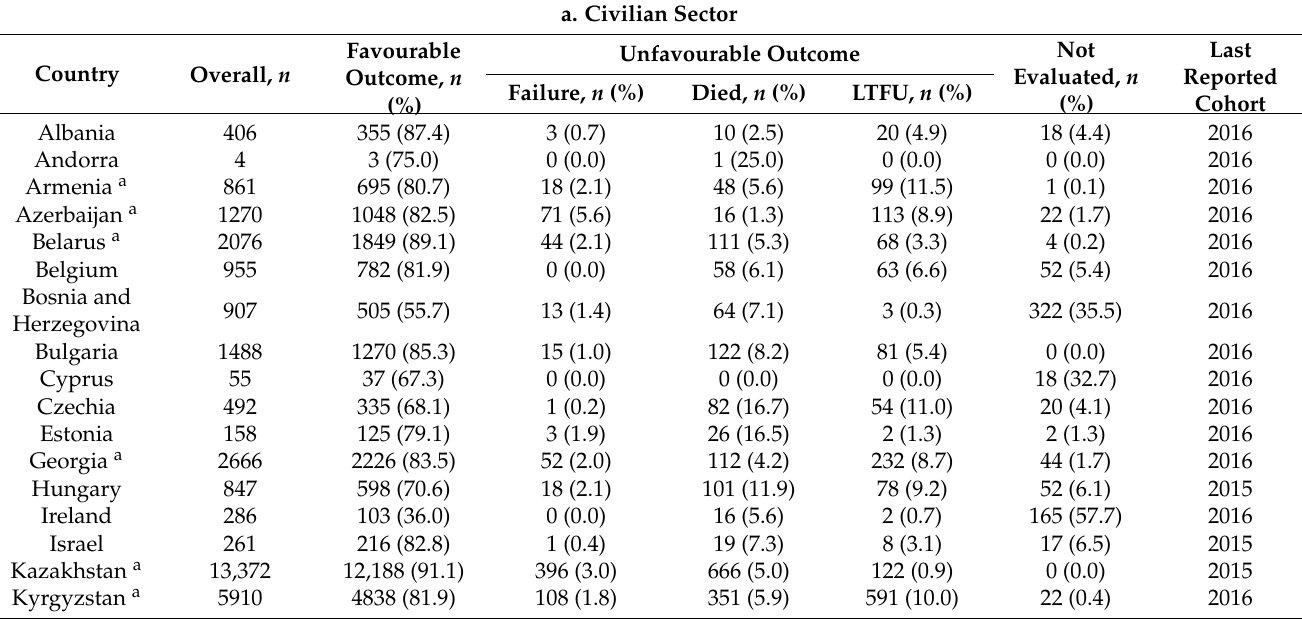
Table 4. Favourable and unfavourable TB treatment outcomes for civilians and inmates on first-line drug treatment schemes, 2012–2016 cohorts, WHO European Region.